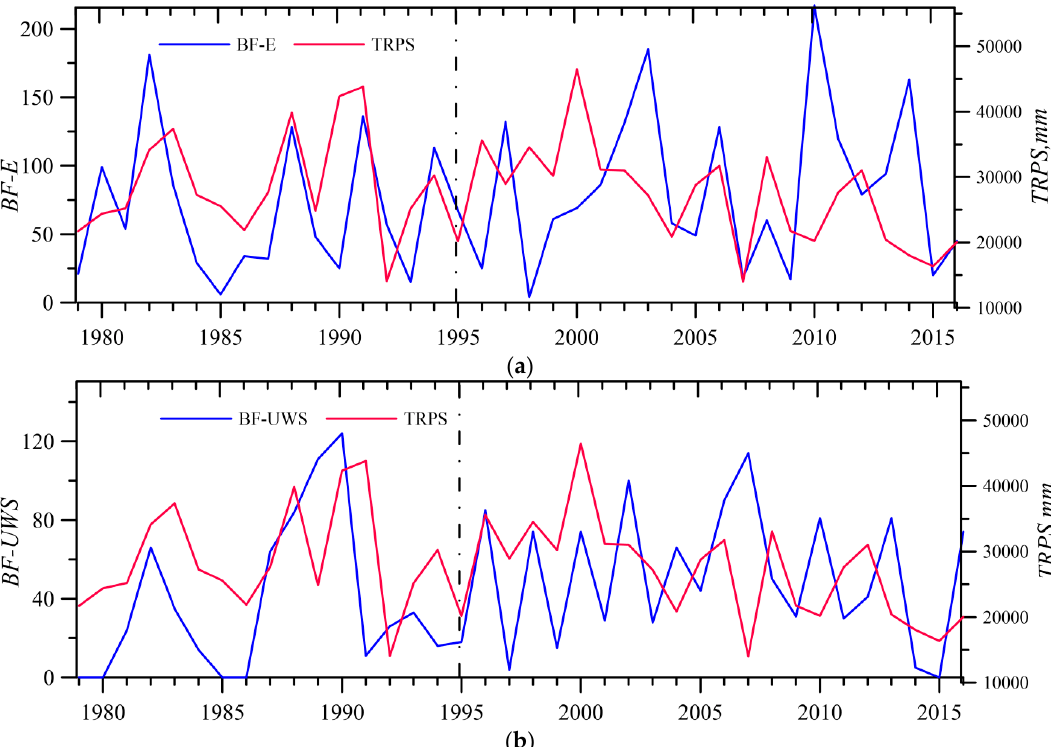
Figure 6. Interannual changes in E-blocking frequency (E-BF) and TRPS ( a ), and UWS-blocking frequency (UWS-BF) and TRPS ( b ).